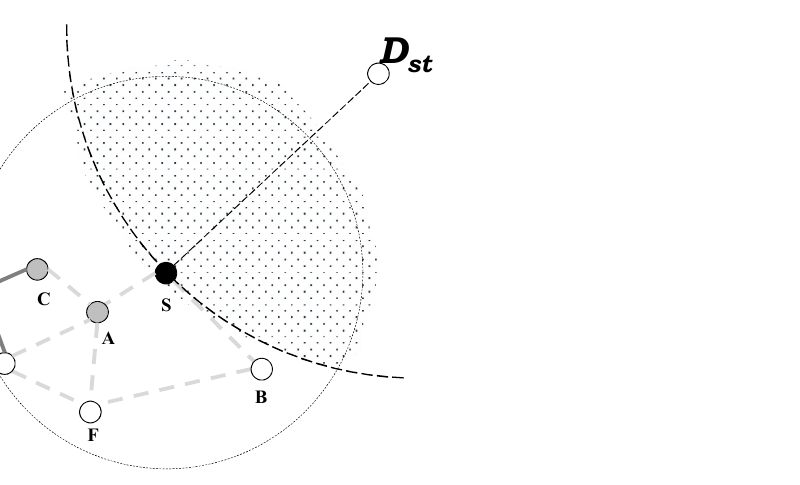
Figure 5. In this search progress, the node S can identify that the node E is not its neighbor